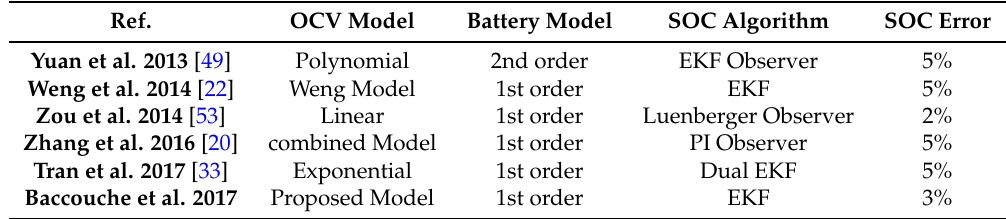
Table 12. Review of model-based SOC estimation approaches’ performances for NMC batteries at 25 ◦ .